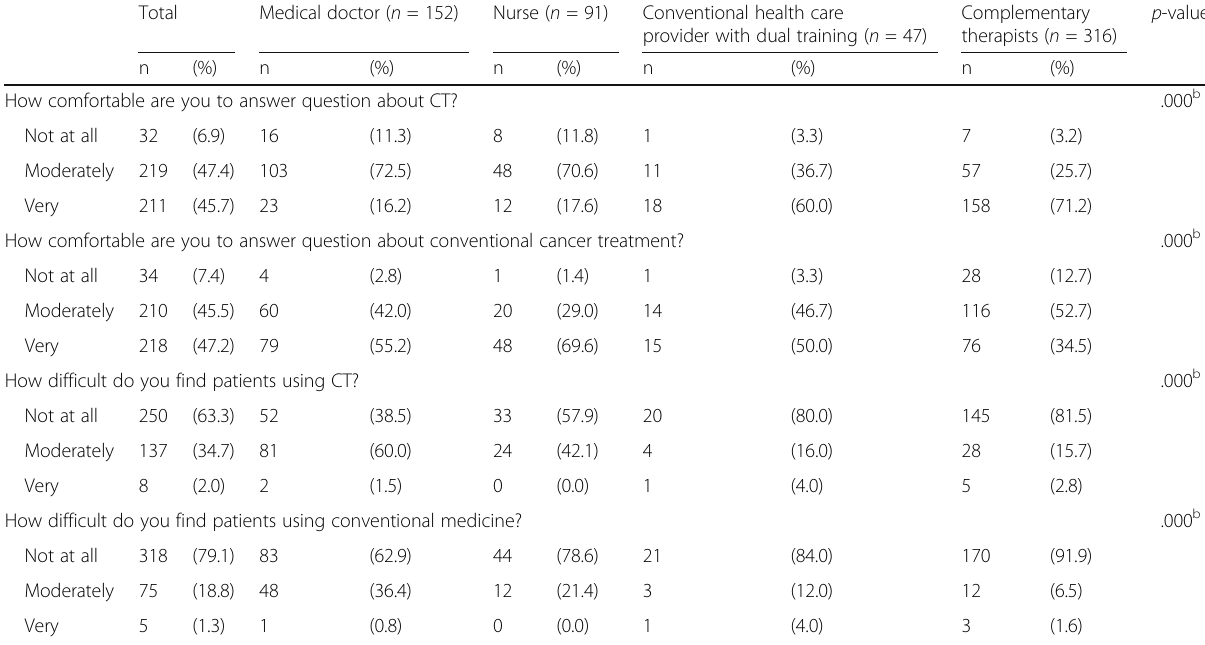
Table 5 Difficulties in provider-patient communication ( n = 606) a Total Medical doctor ( n = 152) Nurse ( n = 91) Conventional health care provider with dual training ( n = 47)